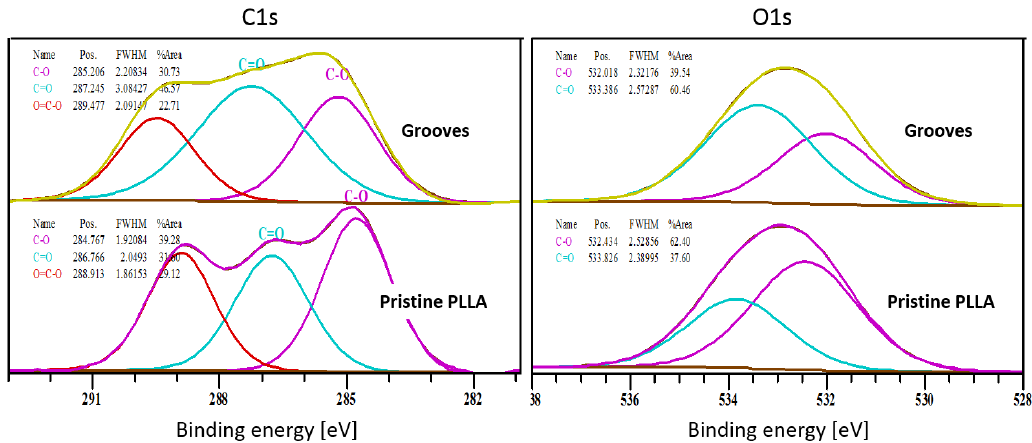
Figure 2. C1s and O1s spectra obtained by XPS on grooved and pristine areas of amorphous PLLA. Table 1. C.O ratios (at %) in the pristine and grooved PLLA surfaces measured by XPS